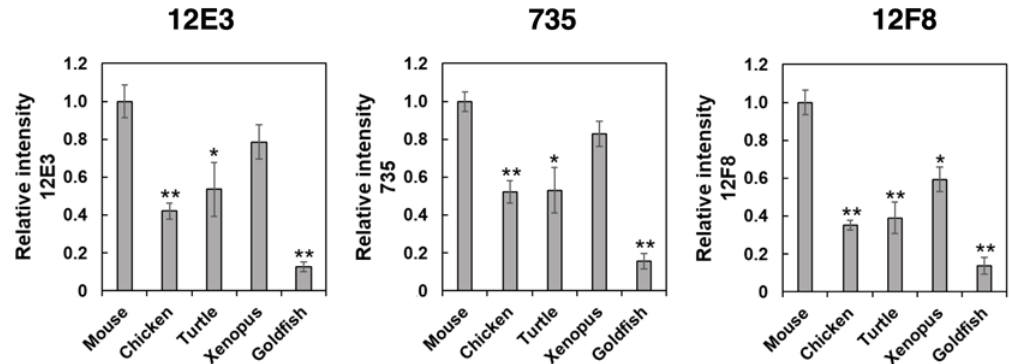
Figure 5. ELISA analysis of polySia-NCAM in brains from five different vertebrates. Brain homogenates (250 ng as protein) from five vertebrates (mouse, chicken, turtle, xenopus, goldfish, n = 3) were immobilized onto a 96-well plate and blocked with 2% BSA. The wells were then incubated with 12E3, 735, or 12F8 antibody before or after the Endo-N treatments. After color development, ELISA values of the Endo-N-treated wells were subtracted from those of the Endo-N-untreated wells. The left, middle, and right panels show the relative binding intensity of the 12E3, 735, and 12F8 antibodies, respectively. Triplicate analyses are shown with error bars. * indicates p < 0.05. ** indicates p < 0.01.